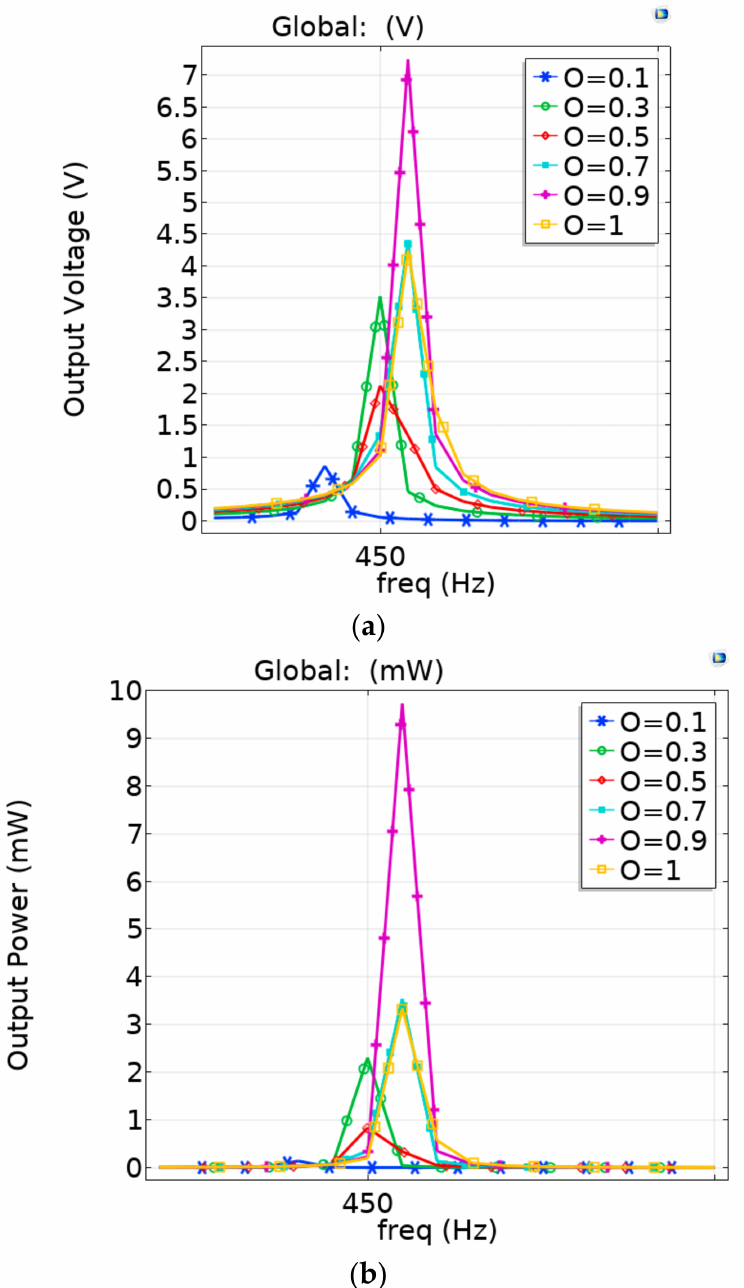
Figure 8. Frequency response of generated output voltage ( a ) and output power ( b ) at the third mode frequency for different tapering ratios of the segmented PVEH for a mechanical input acceleration of 0.5